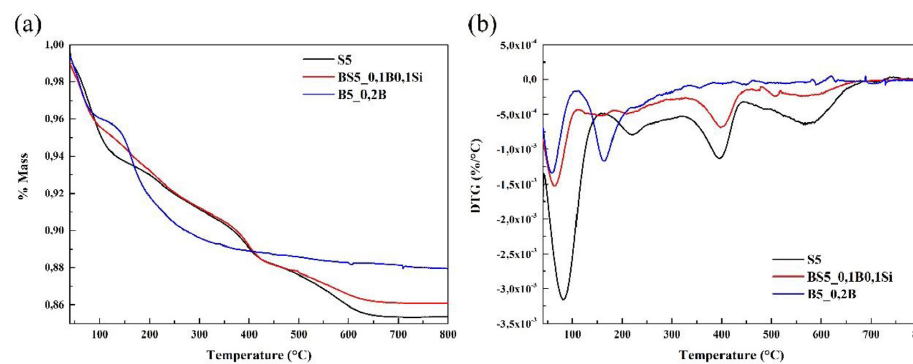
Figure 7. Profiles of (a) TG and (b) DTG of samples S5, BS5_0,1B0,1Si and